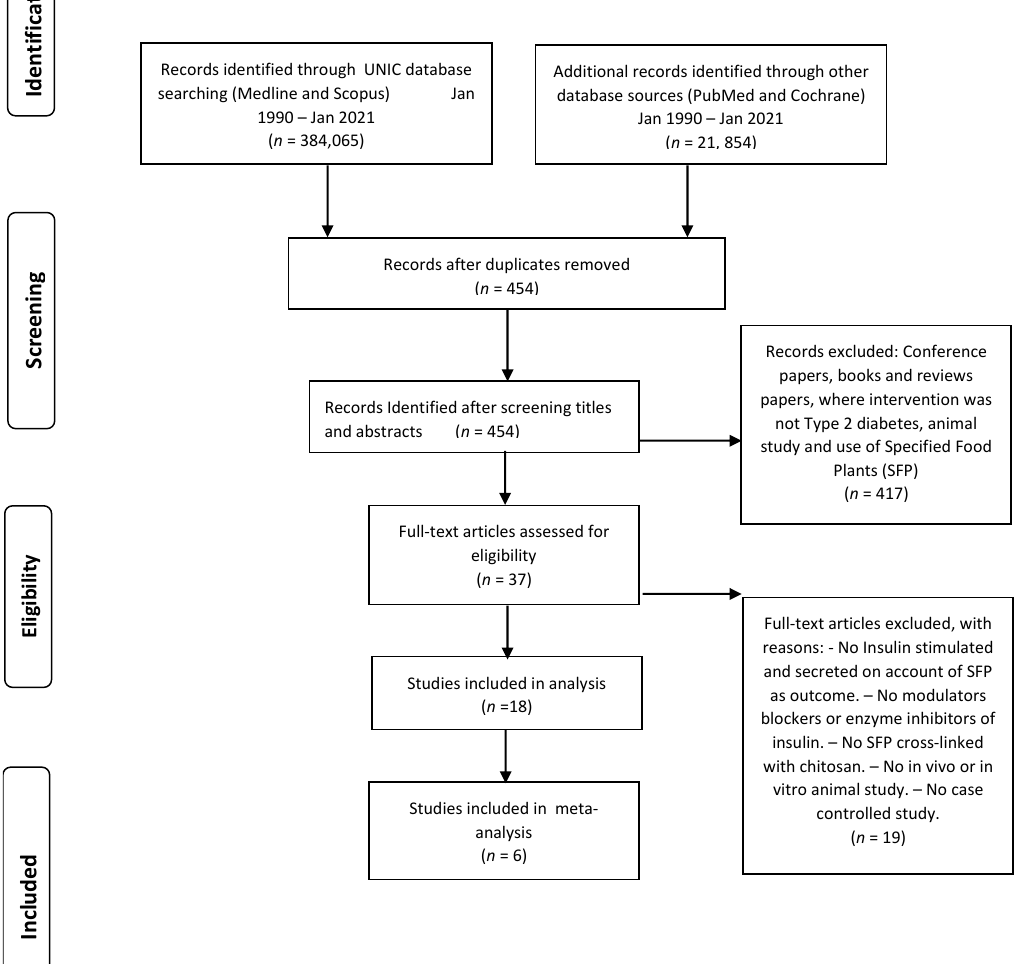
Figure 3. PRISMA flow diagram of included articles .